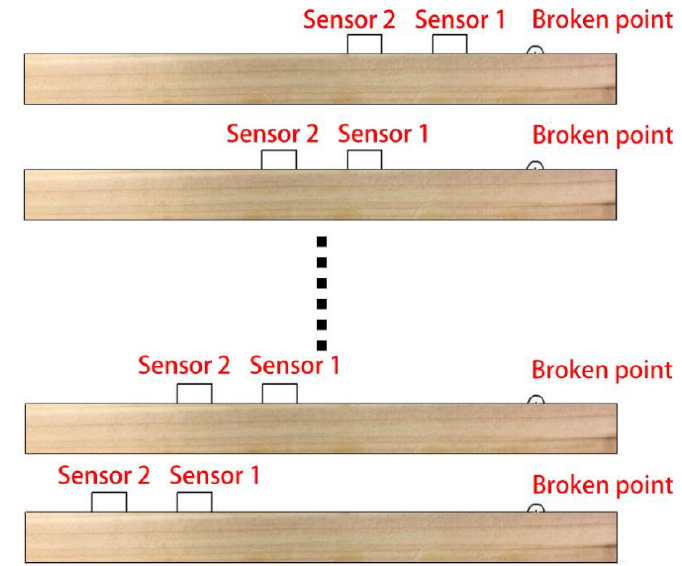
Figure 2. Lead breaking test scheme.